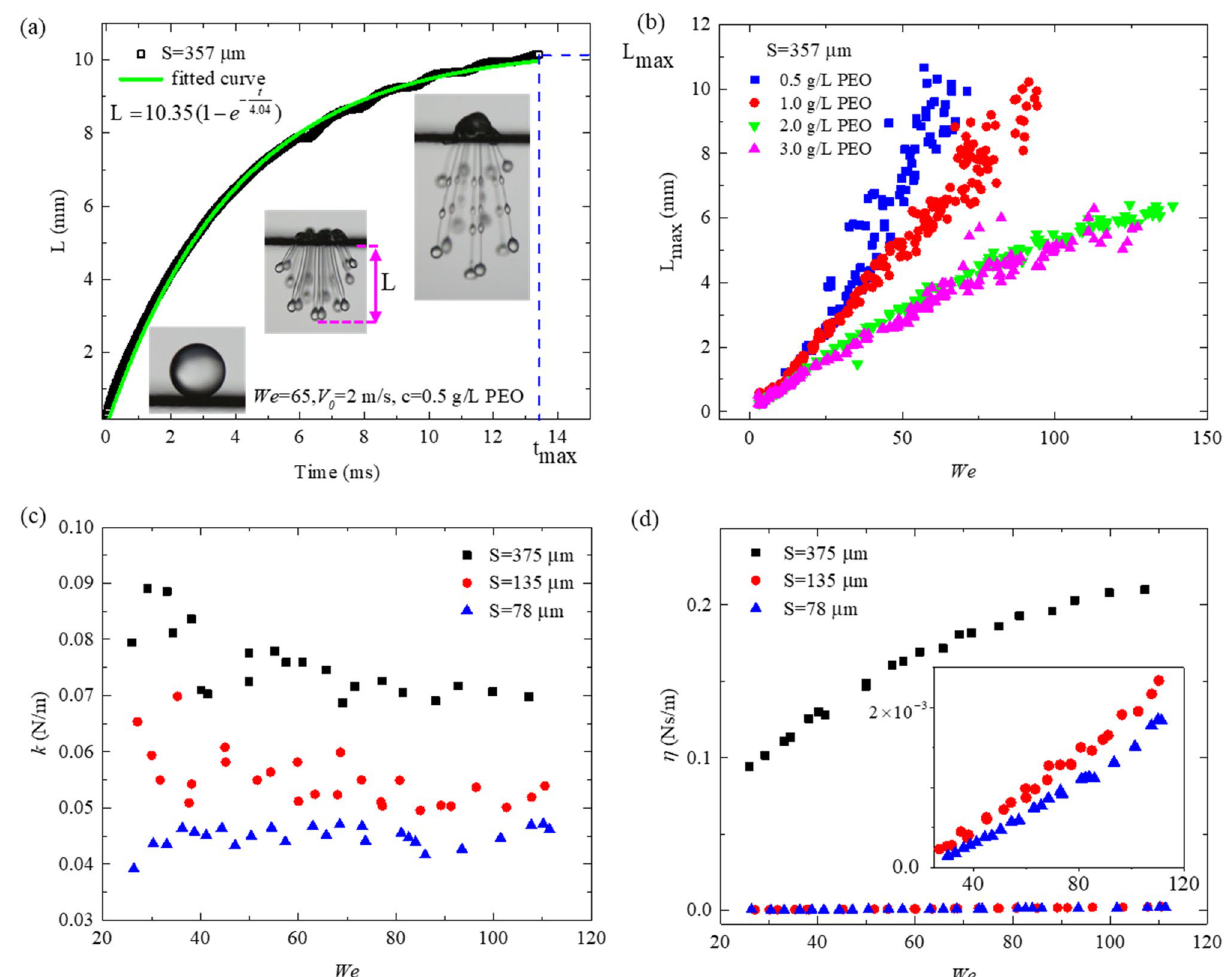
Figure 3. The ligament dynamics. ( a ) Tiem evolution of the ligament length for meshes with pore sizes S = 357 μm at We = 66 and 0.5 g/L PEO concentration. The solid green line shows the fitted curve by the spring- damper equation of motion. ( b ) The maximum ligament length versus the Weber number for meshes with pore sizes S = 357 μm and different PEO concentrations. ( c ) The spring constant and the ( d ) damper coefficient were extracted from the spring-dashpot